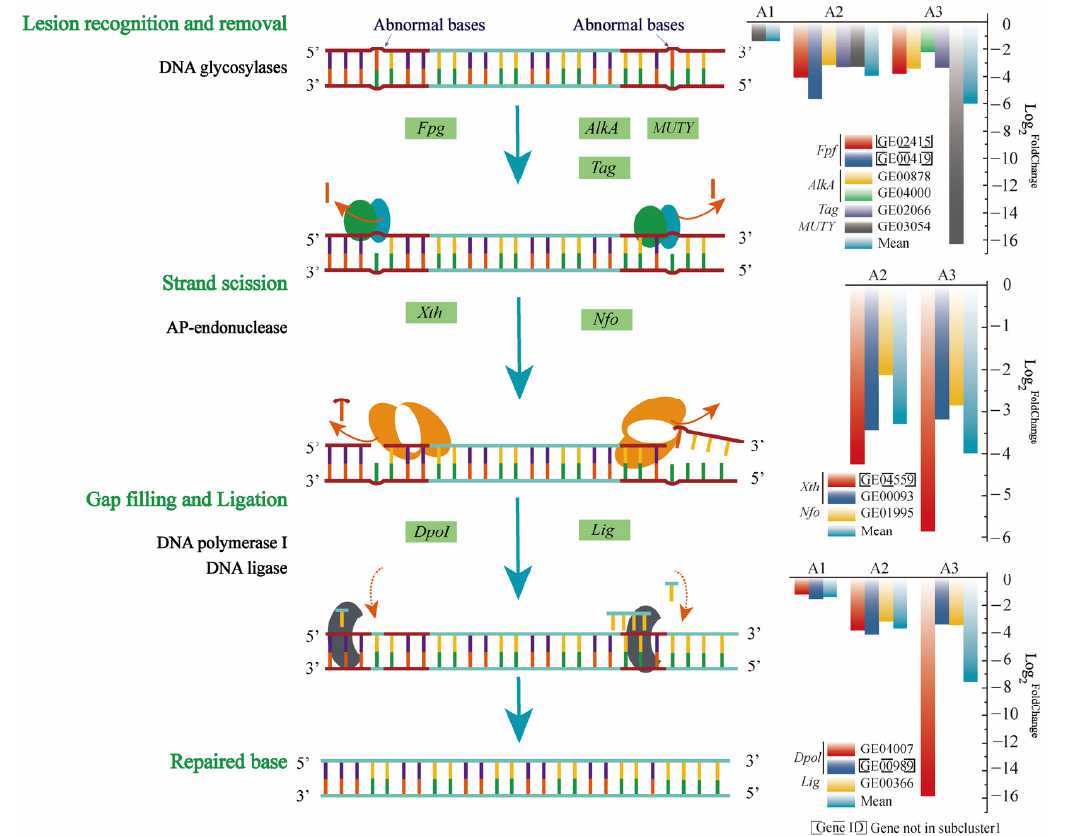
Figure 5. DNA excision repair mechanisms and gene expression levels in R-001 under BPA stress. A dashed border around a gene symbol indicates that this gene did not belong to subcluster 1 but was involved in the DNA excision repair process.